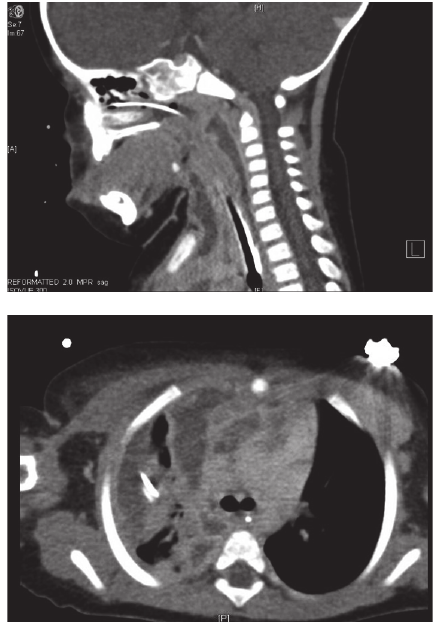
Figure 1: Sagittal and transverse CT images.